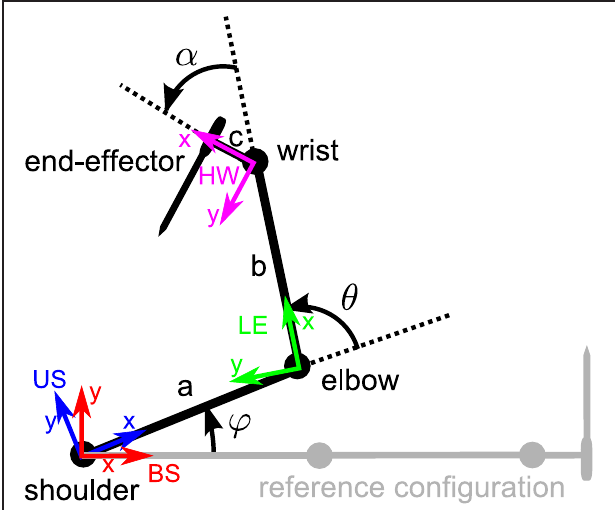
FIGURE 5 | seven-dof three-link arm top view. The shoulder insertion point, elbow and wrist are represented as well as the end-effector (a screwdriver) location and orientation. The different reference frames are also represented: body-fixed shoulder-centered ( BS , in red), upper arm -fixed shoulder-centered (US, in blue), lower arm -fixed elbow centered (LE, in green), and hand-fixed wrist-centered (HW, in magenta). The rotation angles of the shoulder, elbow, and wrist are respectively denoted ϕ , θ , and α . The configuration in gray represents the reference